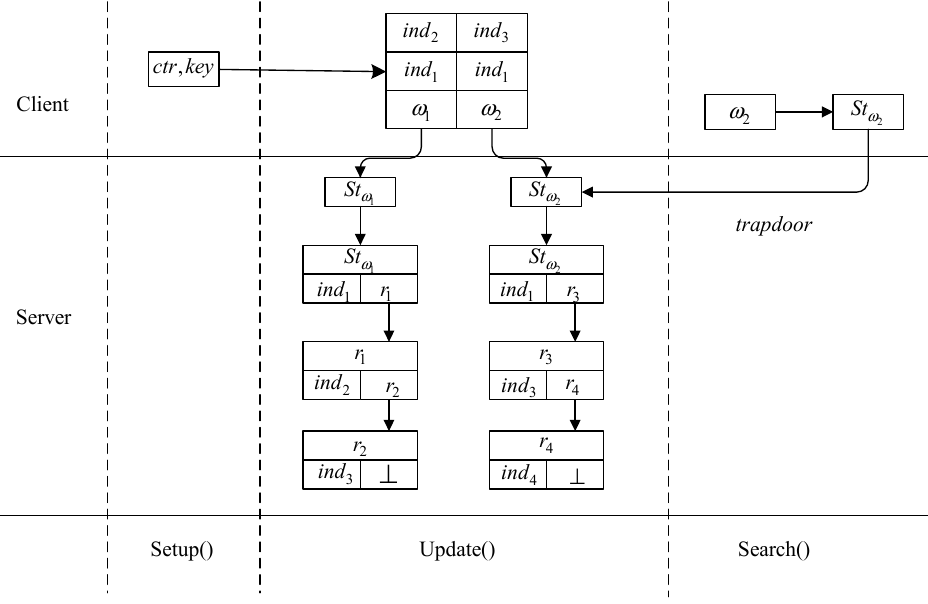
Figure 2. Server operation process.